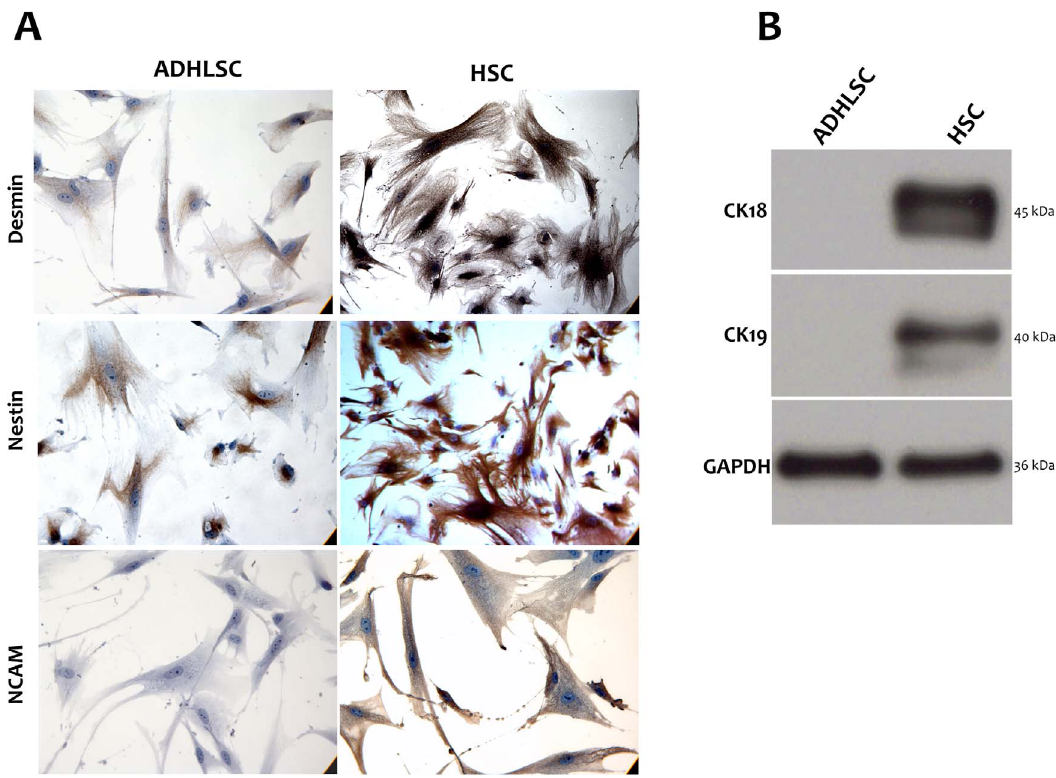
Figure 3. Immunodetection comparative study. A, HSCs show a positive immunostaining for neural markers like NCAM and nestin and for desmin. The expression level of nestin and desmin is higher in HSC in comparison with ADHLSC. ADHLSC do not express NCAM at the protein level. Images are representative of several fields examined from four different donors. Magnification 400 6 . B, Total proteins were extracted from ADHLSC and HSC and CK-18 and CK-19 immuno-detection was realized using western blotting. Data shown are representative of 4 different cell samples isolated from 4 different donors.